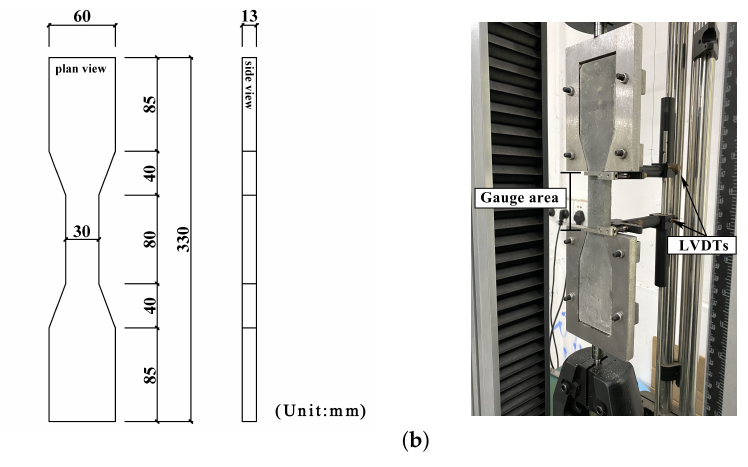
Figure 4. Uniaxial tensile test. ( a ) Geometry of the specimen and ( b ) schematic diagram of the test